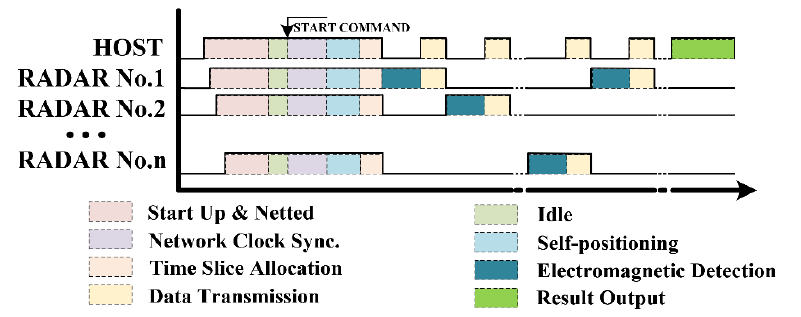
Figure 5. The workflow timing.